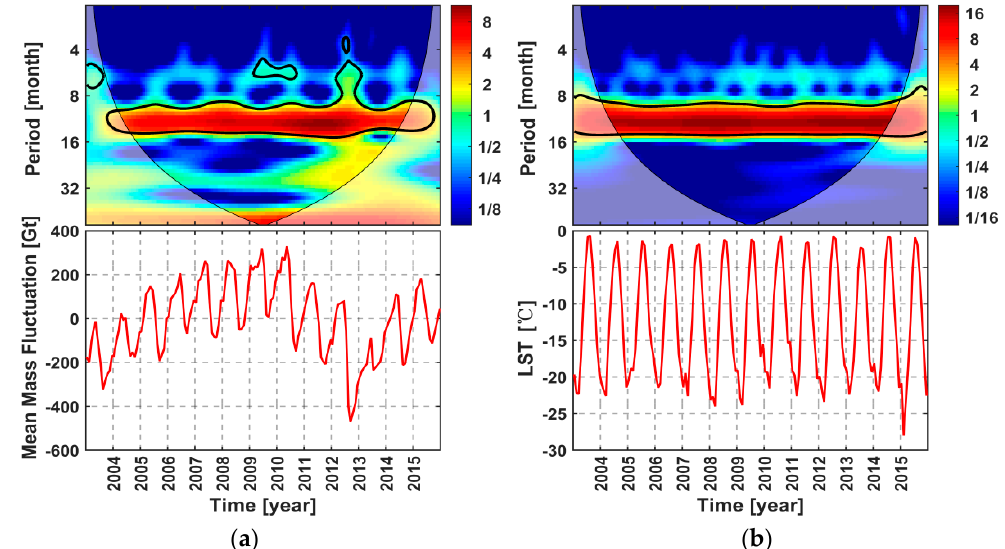
Figure 8. Continuous wavelet transform with average mass and land surface temperature represented by ( a ) and ( b ) from 2003 to 2015.